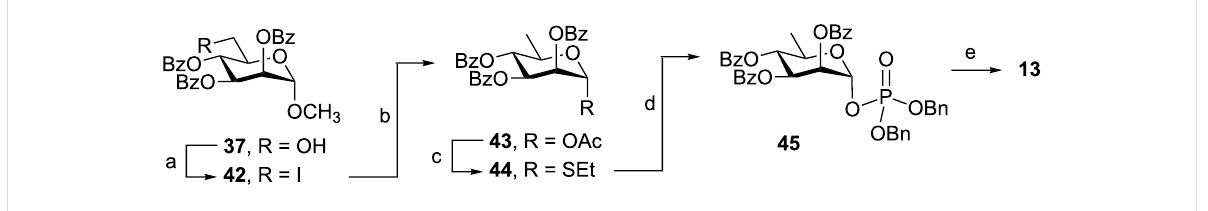
Evaluation of 9 – 13 as substrates for GDP- Man